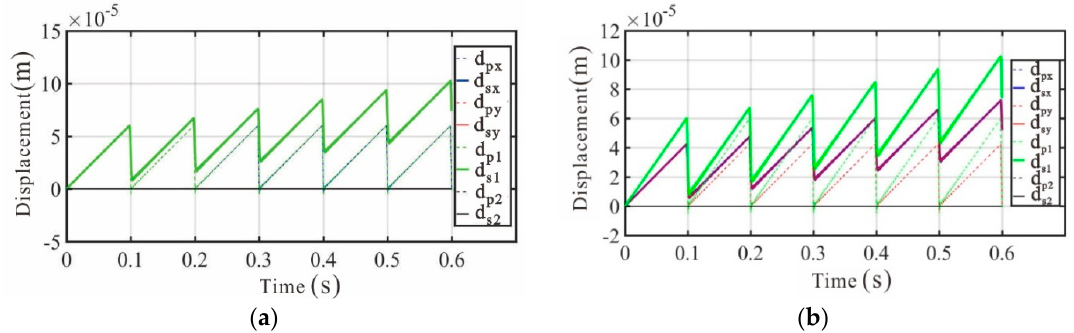
Figure 5. Model comparison: ( a ) 2-DOF PIDM with single input; ( b ) The driving voltage of the 1-DOF PIDM is √ 2 times than that of the 2-DOF PIDM in the direction of the x -axis ( y -axis).